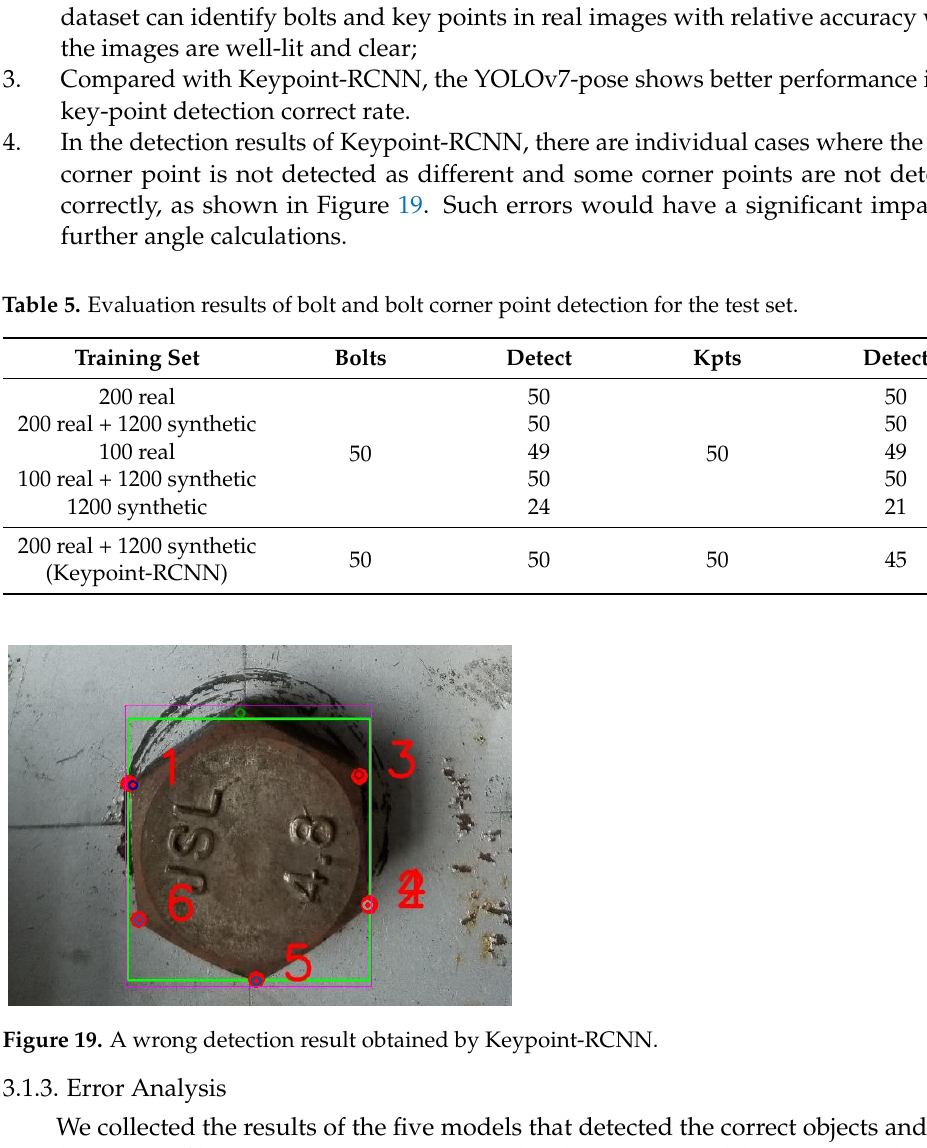
( b ) Figure 20. Detection box and key-points visualization ( a ) Detection results of the “ 100 real ” model; ( b ) Detection results of the “ 200 real + 1200 synthetic ” model. In order to be able to evaluate quantitatively, we used the normalized mean error (NME) to evaluate the performance of different models. The error was calculated as Equa- tion (9). To represent the error more intuitively, we also used Equation (10) to convert the NME into an angular form.